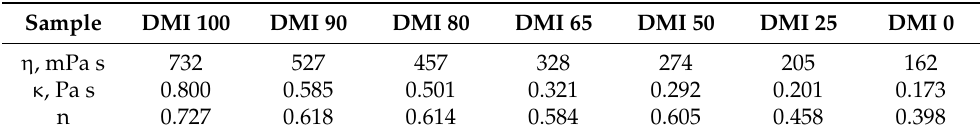
Table 1. Ostwald–de Waele parameters and viscosity of the resins at 25 ◦ C. Table 1. Ostwald – de Waele parameters and viscosity of the resins at 25 °C.